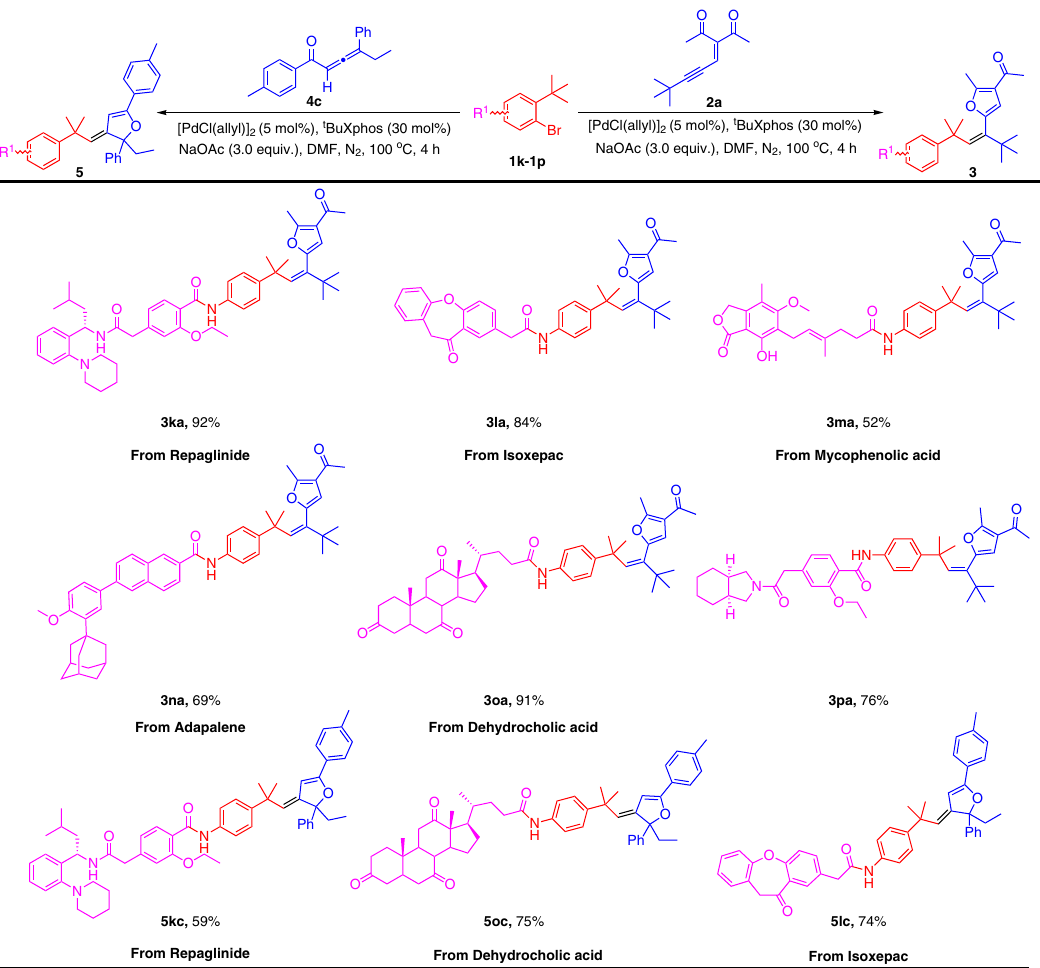
Fig. 4 Substrate scopes of complex aryl bromides from modi fi ed drug molecules. [a] Reaction conditions: 1k – 1p (0.1 mmol, 1.0 equiv), 2a or 4c (0.2 mmol, 2.0 equiv), [Pd(Cl(allyl)] 2 (5 mol%), t BuXphos (30 mol%), NaOAc (3.0 equiv), DMF (1 mL), under N 2 , 100 °C, 4 h. Yields of isolated